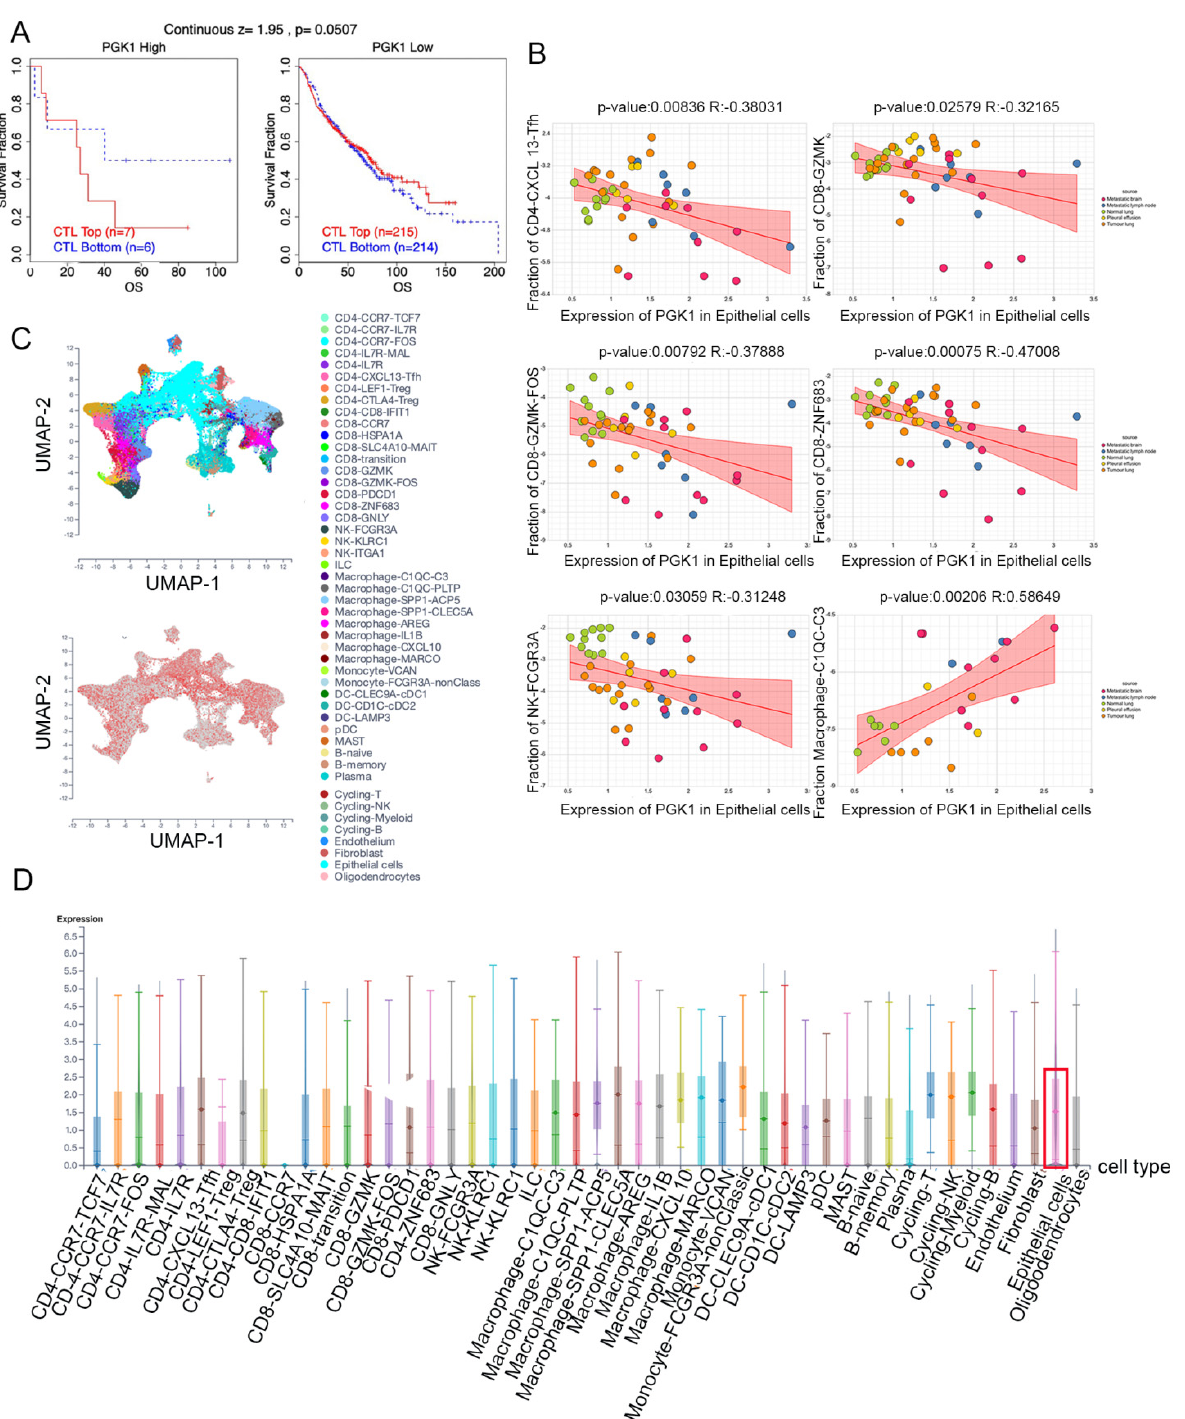
Figure 8. Evaluation of PGK1 expression in tumor cells and immune cells in single-cell level. ( A ) Effect of PGK1 expression on CTL treatment. ( B ) Correlation between PGK1 and immune cell infiltration. ( C ) PGK1 expression in tSNE clusters. ( D ) Expression of PGK1 in tumor cells and immune cells.